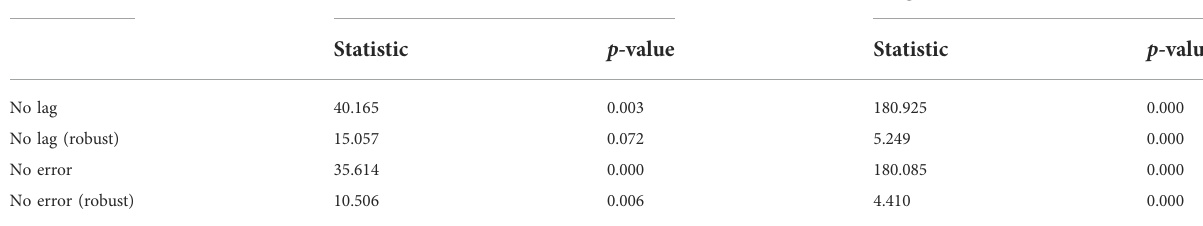
TABLE 6 ML test of the spatial econometric model.